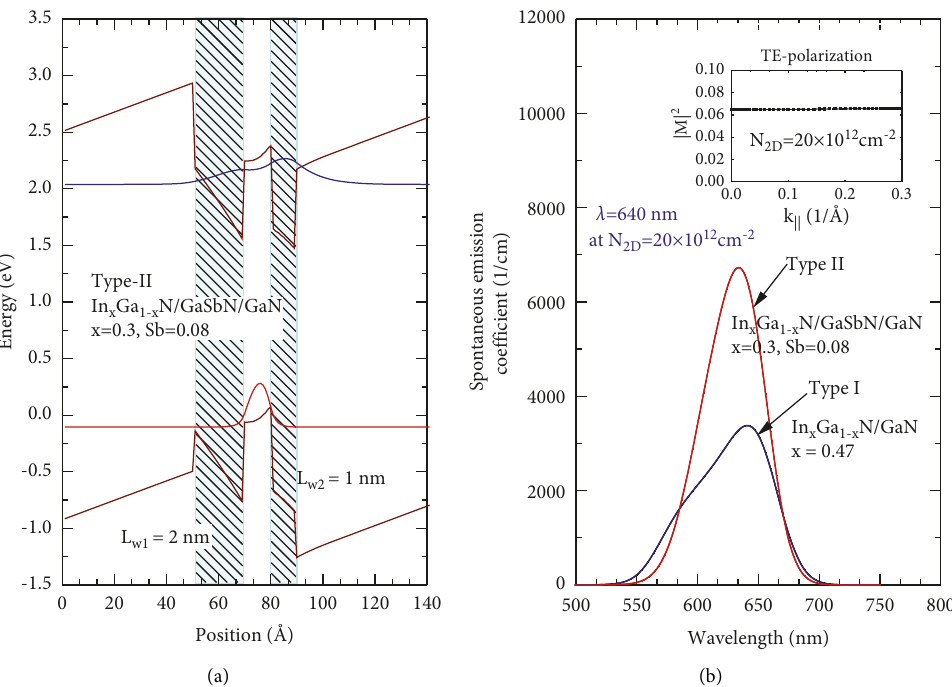
Figure 5: Potential energy profile for (a) the type-II In x � 0.3 and y � 0.08) and (b) TE-polarized x Ga 1 − x N/GaN 1 − y Sb y /GaN QW structure ( spontaneous emission spectra of both the type-I and type-II QW structures. The inset shows the TE-polarized optical matrix element for the type-II In x Ga N/GaN 1 − y Sb y /GaN QW structure ( x � 0.3, y � 1 − x